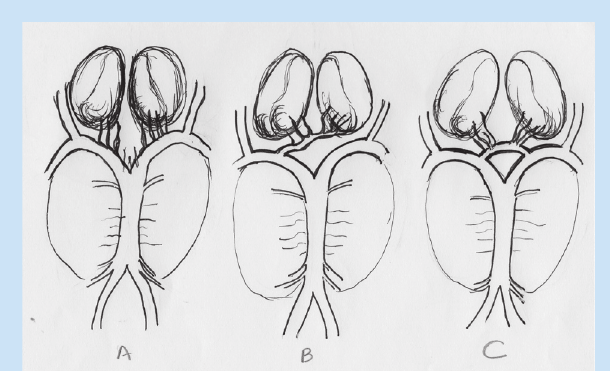
Fig. 5. Schematic diagram. (A). Multiple small perforating arteries arising from the P1 segments of both posterior communicating arteries (most common). (B). A single perforating artery arising from only one of the P1 segments (the artery of Percheron). (C) An arcade of perforating arteries arising from a bridging artery between the P1 segments of the posterior communicating